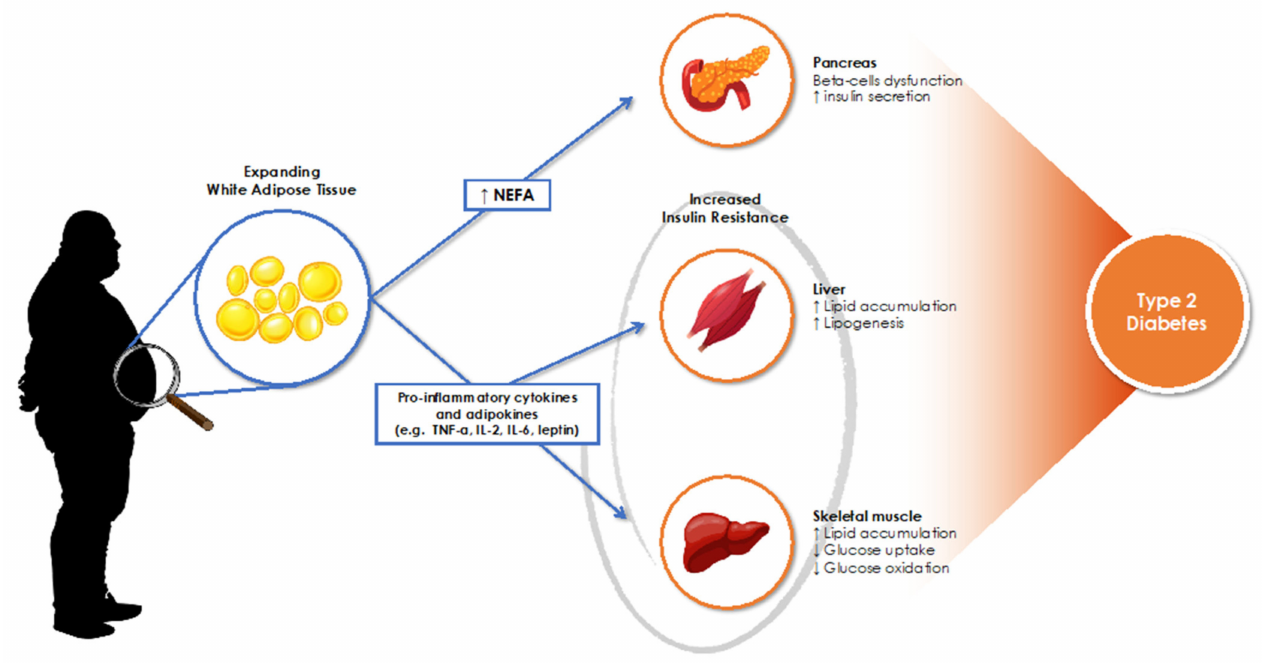
Figure 2. Overview of mechanistic links between obesity and type 2 diabetes. NEFA: Non-esterified fatty acids. Large arrows indicate